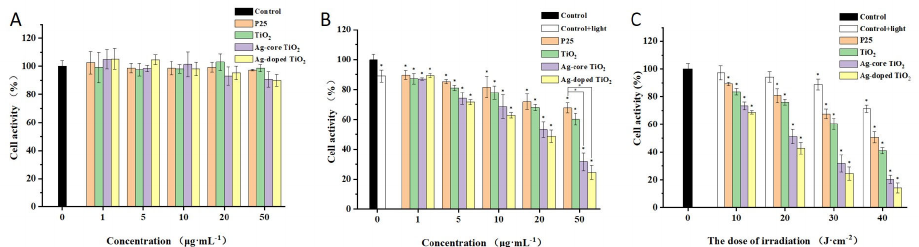
Figure 4. The cytotoxicity assay and phototoxicity of Ag ‐ modified TiO 2 through a CCK ‐ 8 assay; ( A ) Cell viability without irradiation—the cytotoxicity assay of Ag ‐ modified TiO 2 compared with P25 and the synthesized TiO 2 ; ( B ) Cell viability after irradiation by daylight—the phototoxicity assay of Ag ‐ modified TiO 2 compared with P25 and the synthesized TiO 2 with different concentrations of TiO 2 ; ( C ) Cell viability after different irradiation dosage—the phototoxicity assay of Ag ‐ modified TiO 2 compared with P25 and the synthesized TiO 2 . *, p < 0.05, represents statistically significant difference between P25, the synthesized TiO 2 , Ag ‐ core TiO 2 , the Ag ‐ doped TiO 2 group, and the control group.